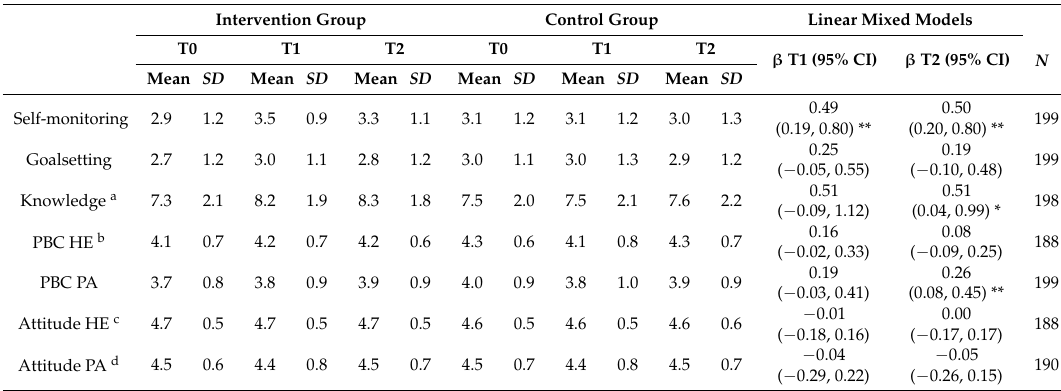
Table 3. Changes in self-monitoring and goalsetting and effects of the PhysioDom HDIM intervention on knowledge, perceived behavioural control, and attitude.